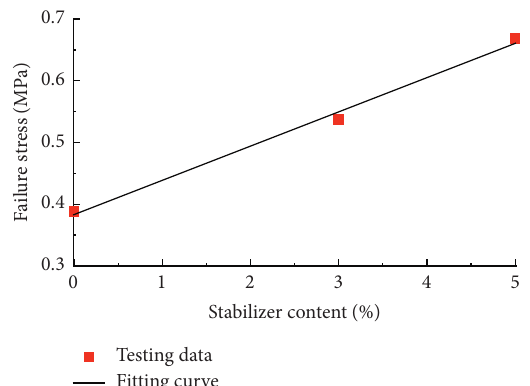
Figure 15: Deviatoric strength envelopes for stabilized soils with different stabilizer content (confining pressure � 0.1 MPa; curing time � 3 days).